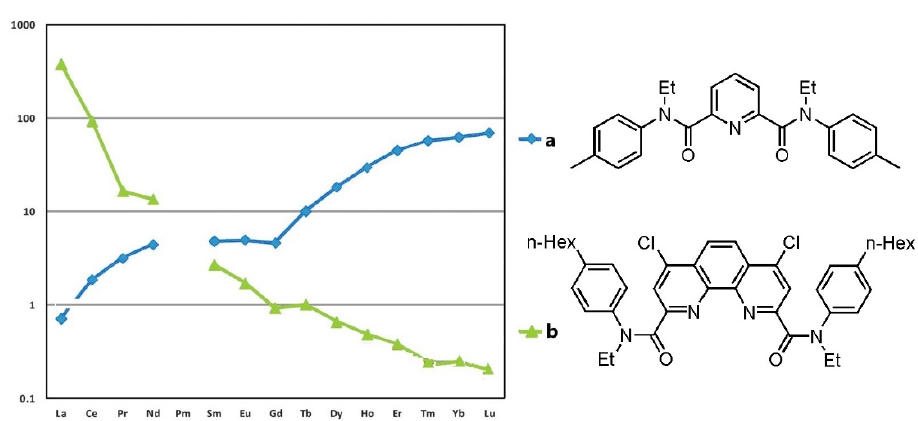
Figure 1. Distribution ratios D of Ln 3+ in the system 3 M HNO 3 /3-nitrobenzotrifluoride (F-3) using ( a ) N , N ’-diethyl- N , N ’-di(p-tolyl)-pyridine-2,6-dicarboxamide and ( b ) N , N ’-diethyl- N , N ’-di(4-n-hexylphenyl)-4,7-dichloro-1,10-phenantroline-2.9-dicarboxamide (adapted from [8]).